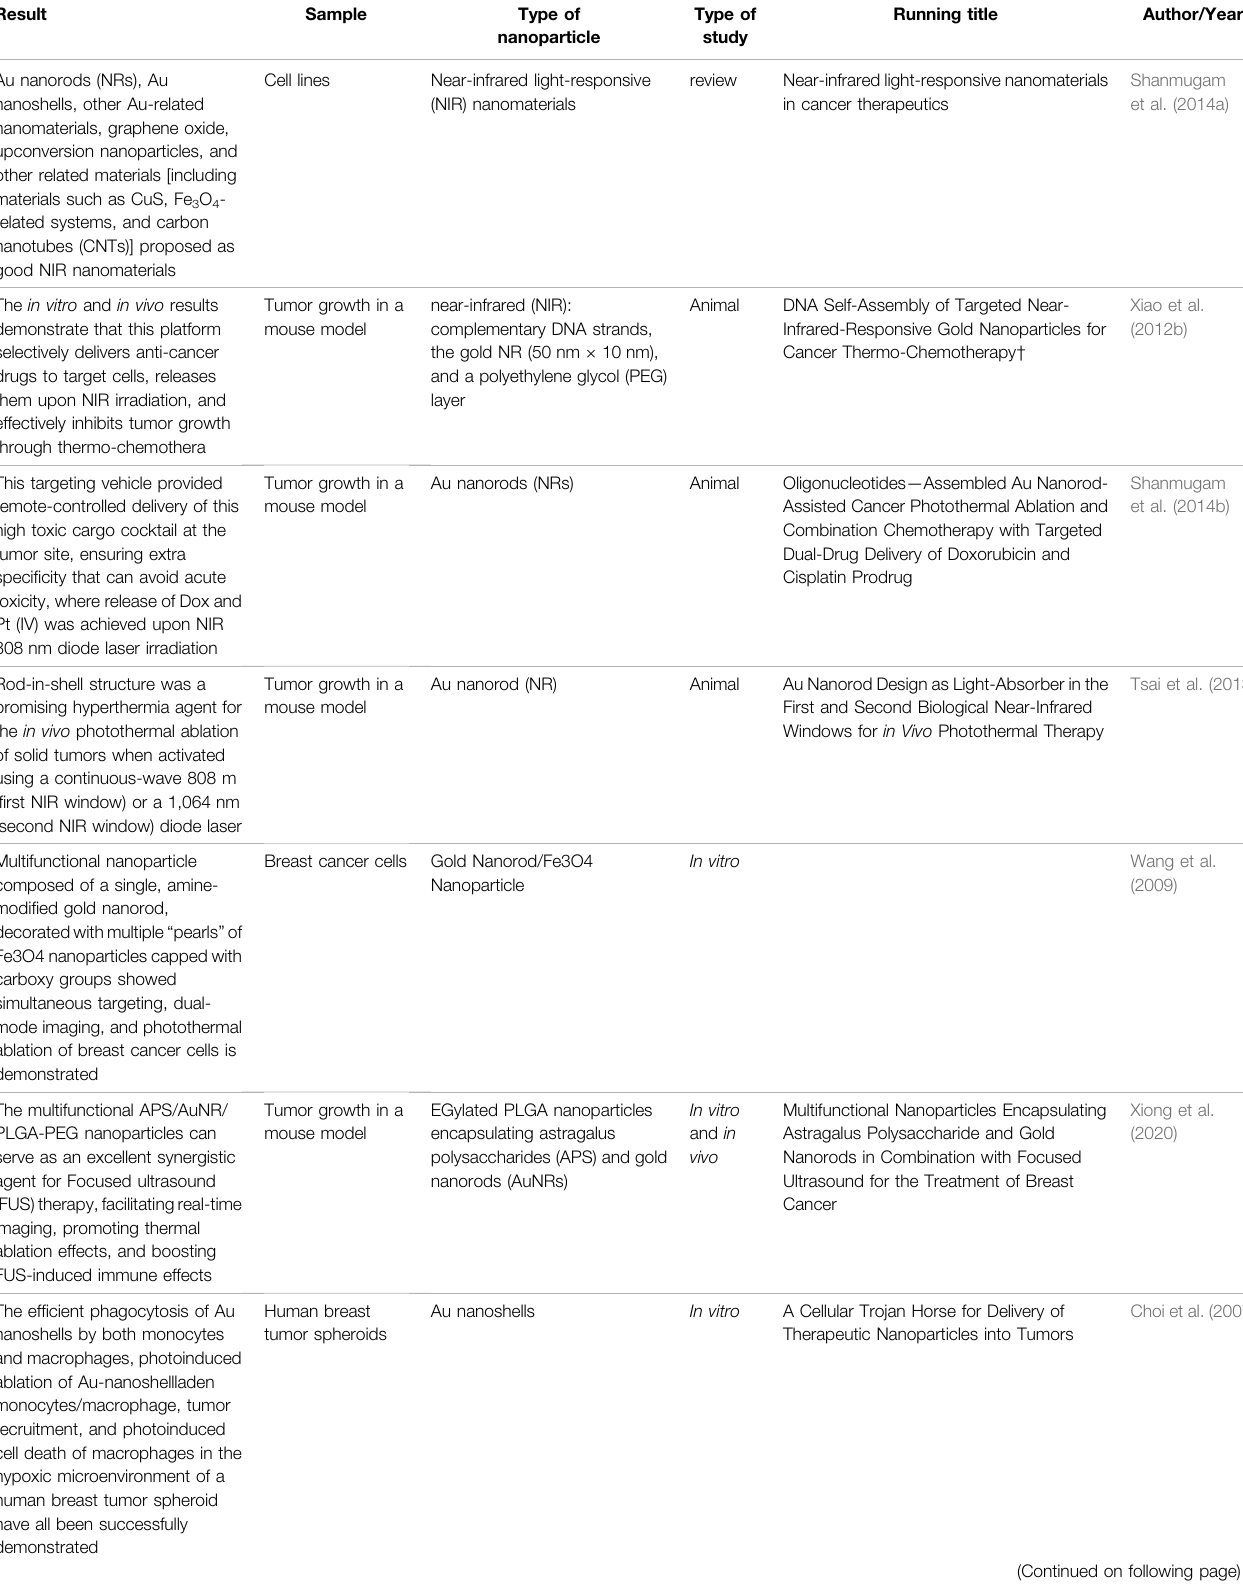
TABLE 1 | Metallic nanoparticles for the modulation of tumor